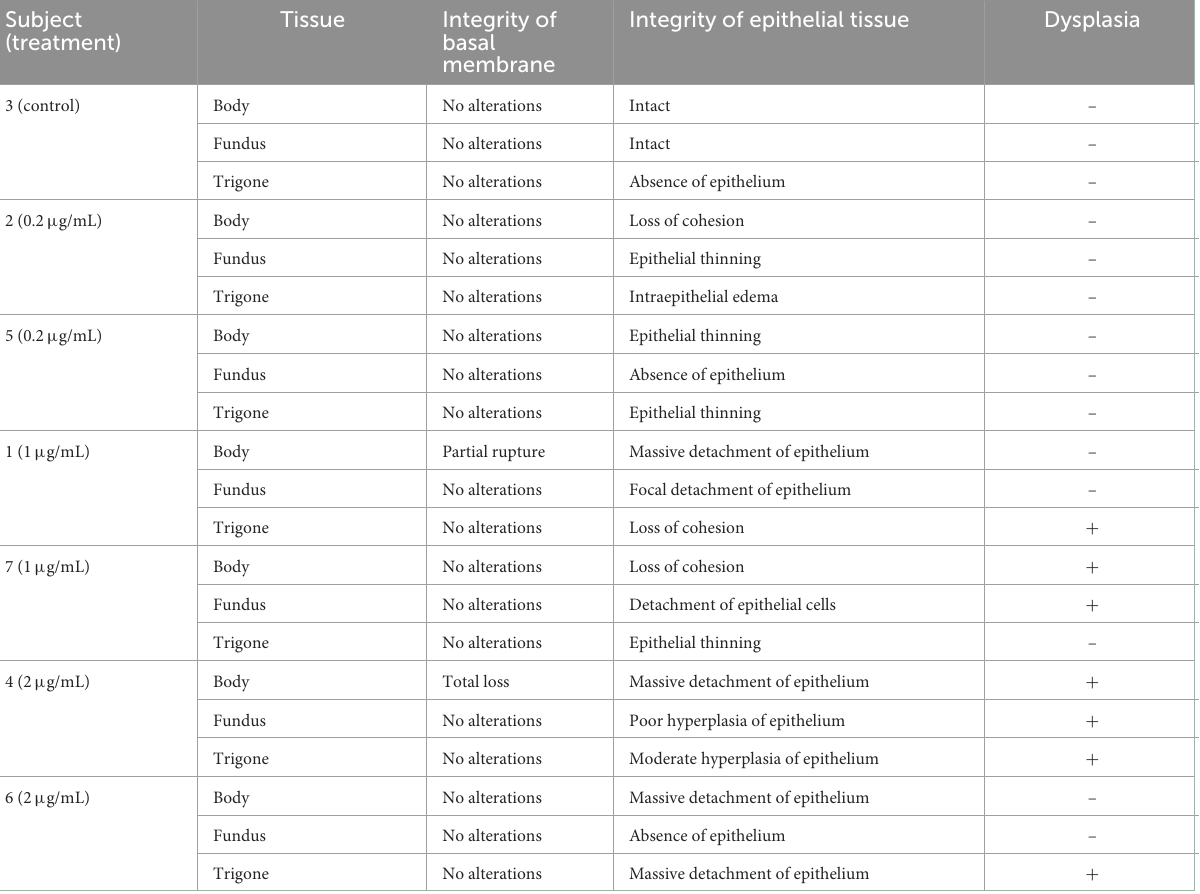
TABLE 1 Histopathological analysis of the basal membrane and epithelium of the bladder of cats 14 days after treatment with 0 (control), 0.2, 1, and 2 µ g/mL of RTX instilled into the urinary bladder. Subject